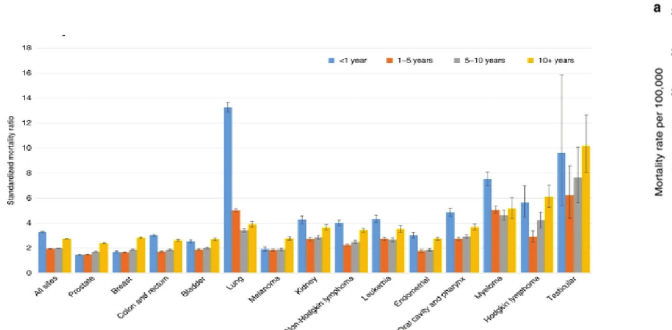
Figure 2 - Standardized mortality ratios (SMRs) of fatal heart disease among cancer patients by cancer subsite